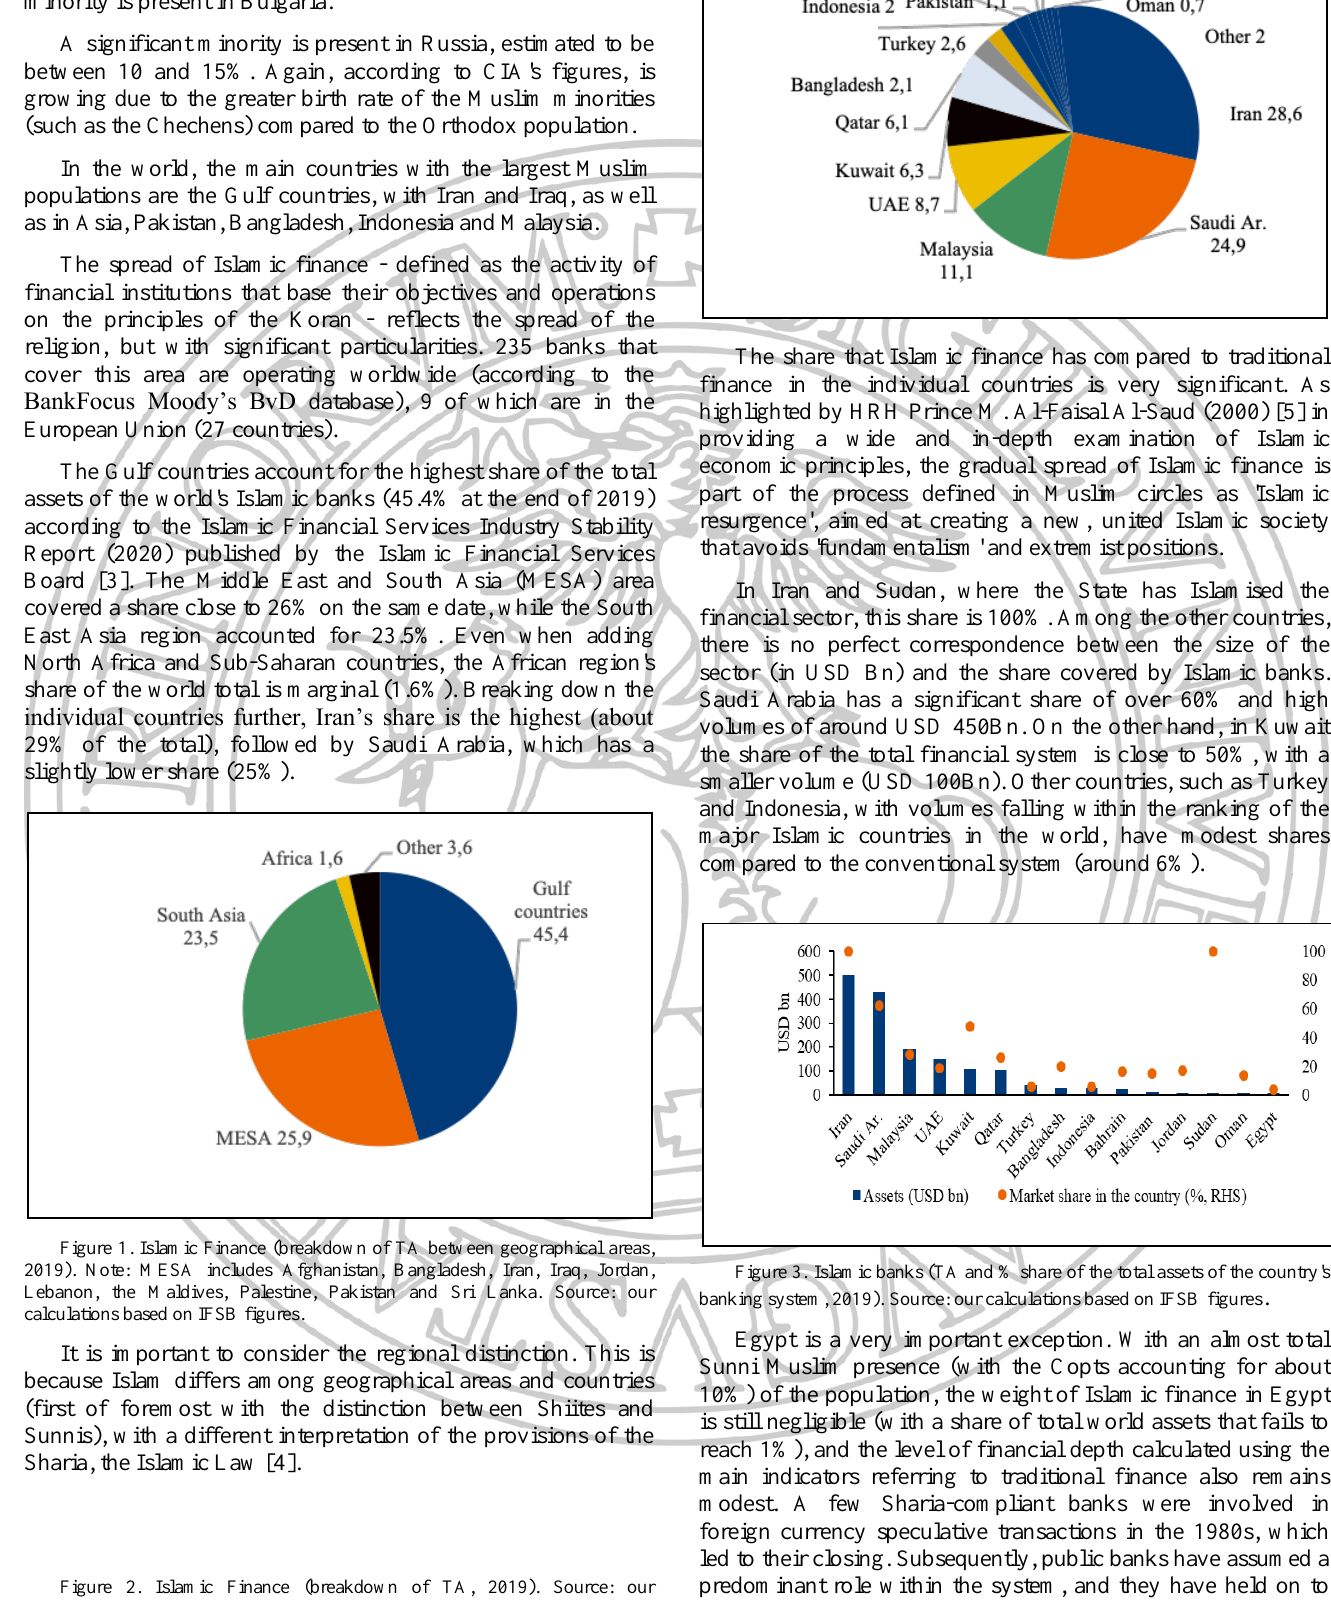
Figure 2. Islamic Finance (breakdown of TA, 2019). Source: our calculations based on IFSB figures .